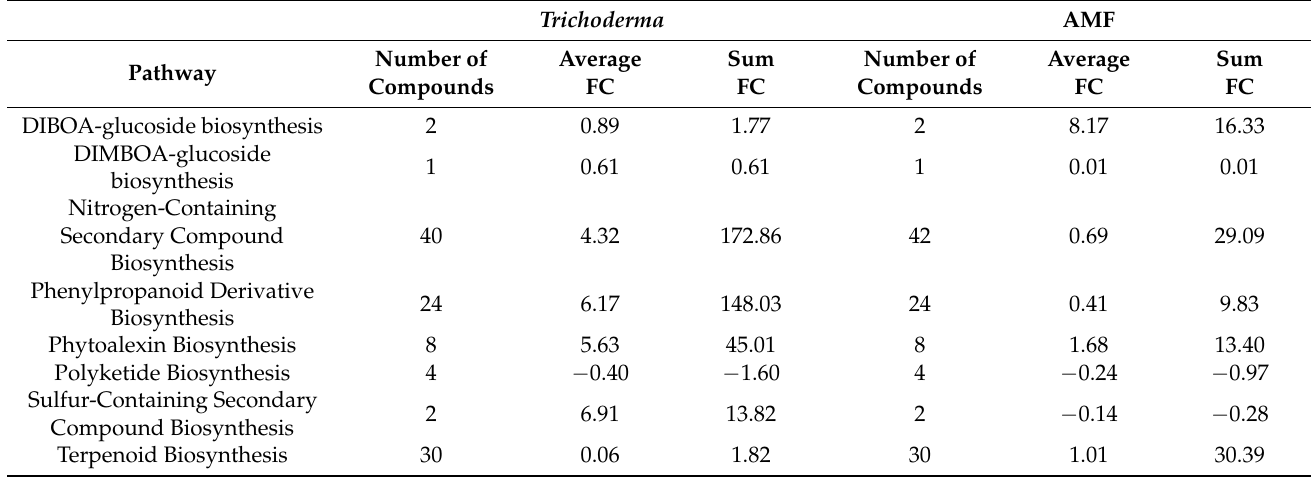
Table 3. Secondary metabolites altered in tomato leaves as a result of the treatments, expressed as total number of compounds, average of log fold-change (FC), and sum of log FC. The metabolomics dataset produced through UHPLC- ESI/QTOF-MS was subjected to ANOVA followed by a FC analysis ( p < 0.05, fold change ≥ 1.5), and differential metabolites were loaded into the PlantCyc Pathway Tool (https://www.plantcyc.org/, accessed on 18 April